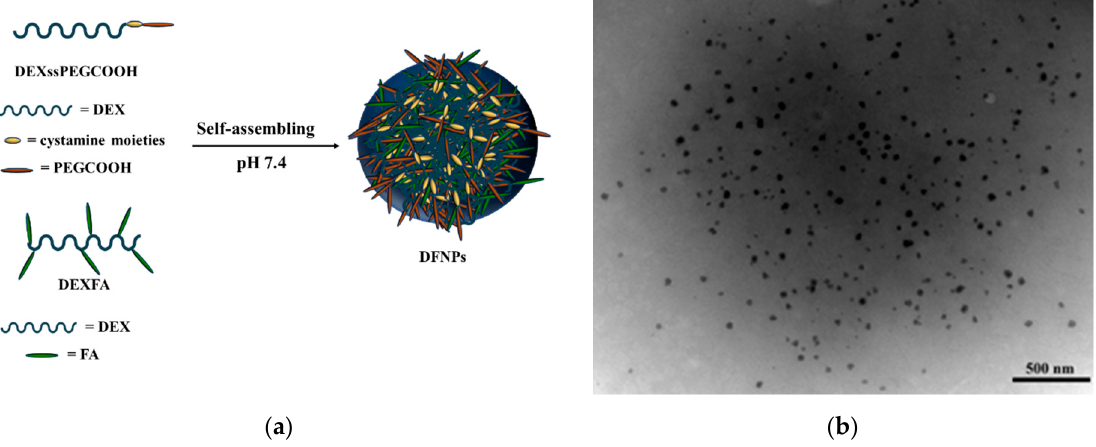
Figure 5. ( a ) Representation of self-assembling process and ( b ) TEM image of DFNPs.